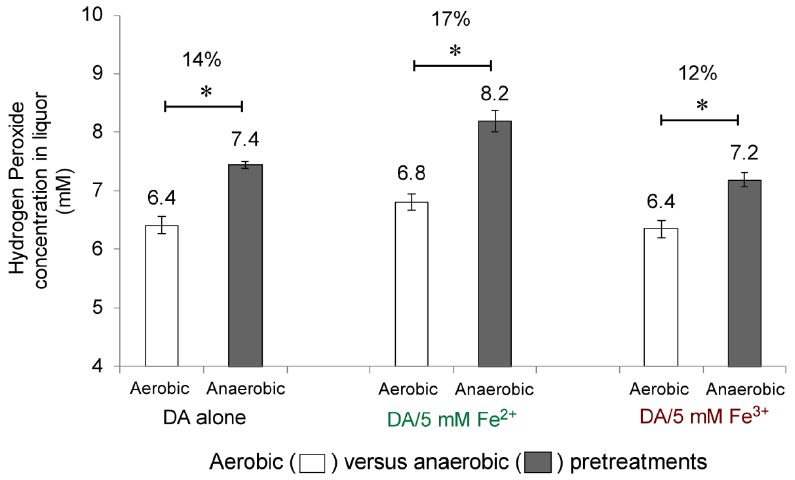
Figure 3. Hydrogen peroxide concentration in liquor after the pretreatment under aerobic versus anaerobic conditions. Asterisk indicates statistically significant difference between the compared two groups (* for p < 0.05). DA, dilute acid.